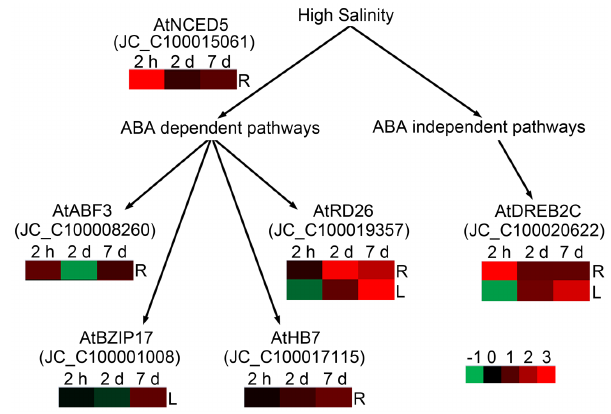
Figure 4. Expression profiles of osmotic signaling related genes. This figure was modified from transcriptional regulatory networks of abiotic stress signals and gene expression [32]. Genes are showed based on alignment with Arabidopsis . Red and green color gradients indicate an increase or decrease in transcript abundance based on log2 transformation of average change fold, respectively. ABF3, abscisic acid responsive elements-binding factor 3; BZIP, Basic- leucine zipper; DREB2, dehydration response element-binding protein 2; HB7, homeodomain leucine zipper protein 7; NCED5, 9-cis- epoxycarotenoid dioxygenase 5; RD26, responsive to desiccation 26; R, Roots; L, Leaves.